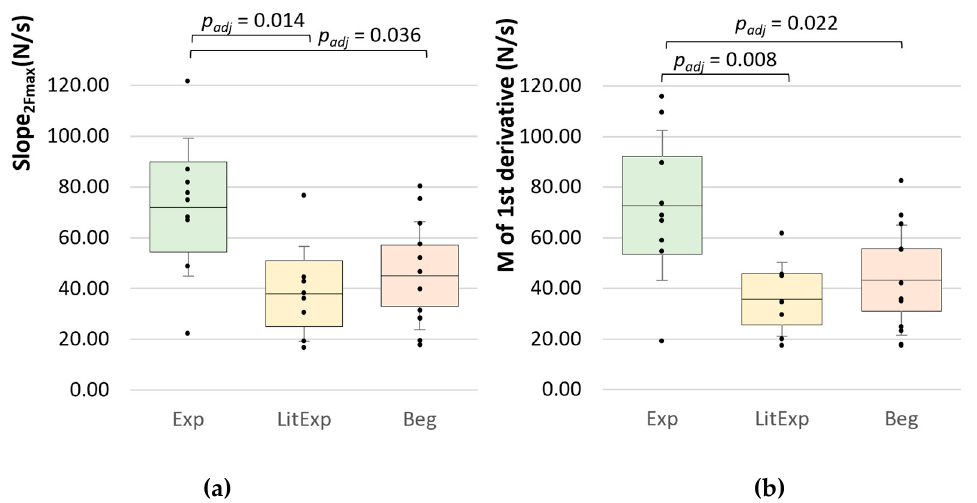
Figure 10. Inter-group comparisons of the overall slope parameters. Displayed are the Ms, SDs (error bars) and 95%-CIs of ( a ) the averaged slope from start to F max (Slope_2max) (N / s) and ( b ) the averaged 1st derivative of the 10 force profiles (N / s) comparing the groups Exp (green), LitExp (yellow) and Beg (orange). Significant comparisons are marked with p adj